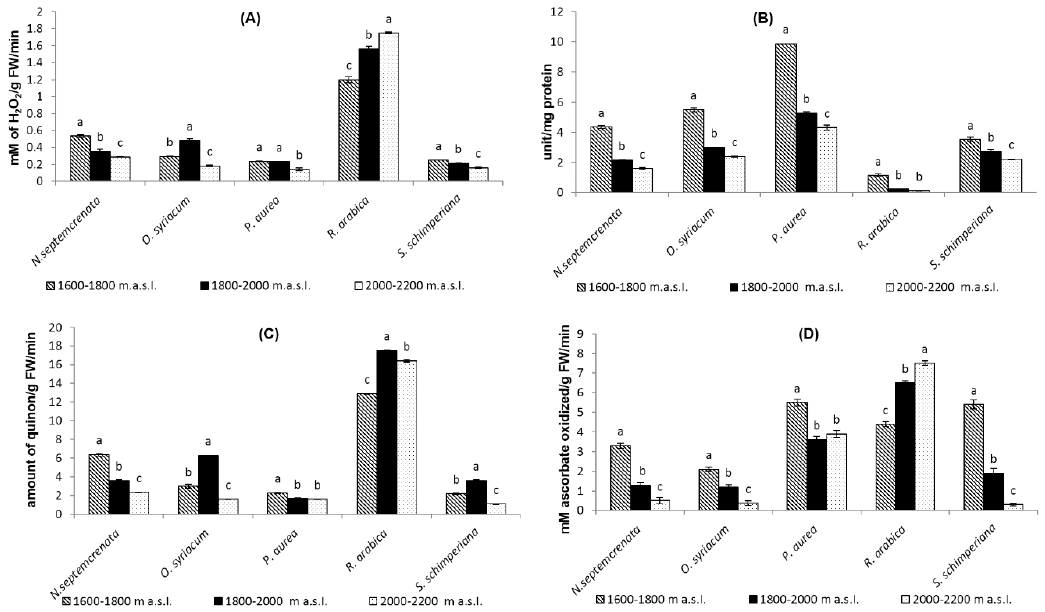
Figure 8. Effect of altitude on the activity of some antioxidant enzymes, catalase ( A ), superoxide dismutase ( B ), ascorbic acid peroxidase ( C ), and polyphenol peroxidase ( D ). Each value is the mean of three replicates ± SE. Bars with different letters are significantly different at p ≤ 0.05.